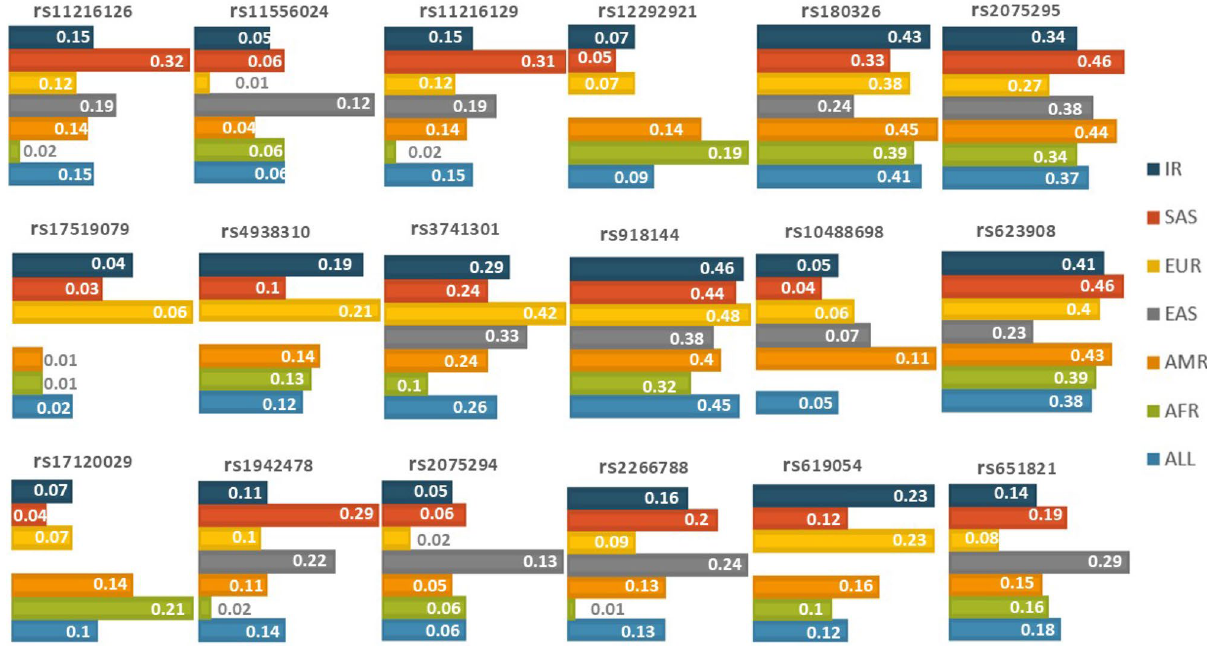
Figure 2. Compares MAF (Minor allele frequency) for 18 SNPs for different populations, Iranian population (IR), and Global minor allele frequency (ALL).